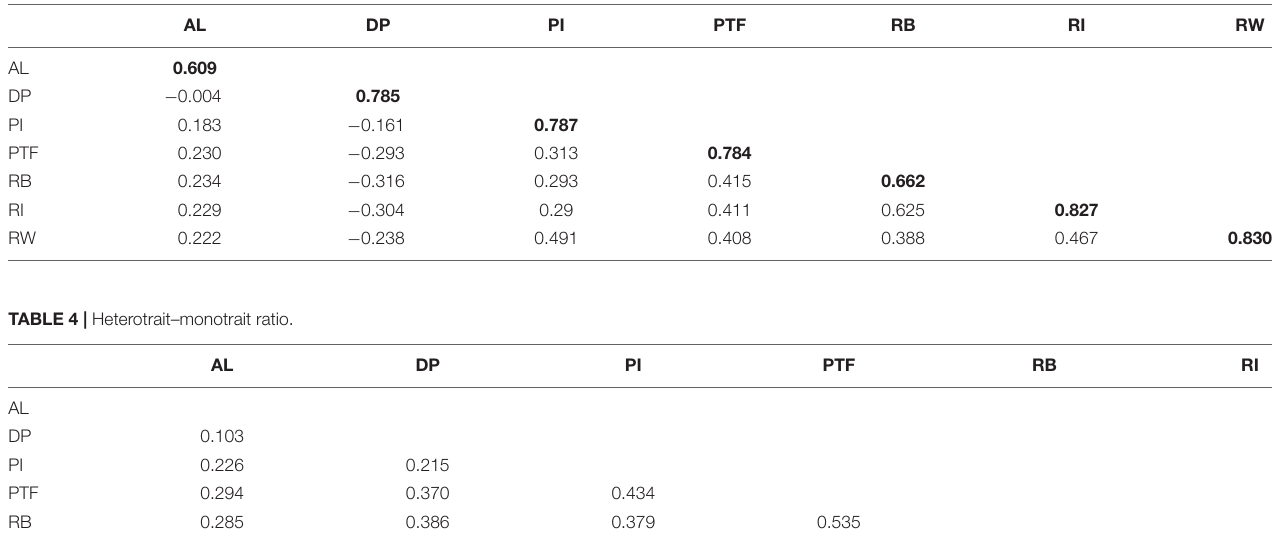
TABLE 3 | Fornell–Larcker criterion.